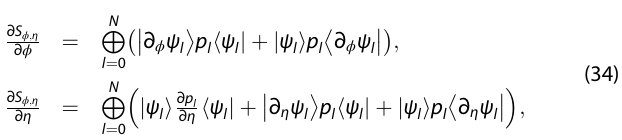
Fig. 3 Schematic for optimal estimation of the phase shift ϕ and interferometer transmissivity η using a two mode state ψ in de fi nite photon-number N . The measurement can be performed in two stages. The fi rst stage (green block) involves performing a projective measurement over the photon-number subspace to determine the number of photons lost, l . The outcome of this measurement is then used to select a three-outcome POVM { Π ( l ) } for the second stage (black box). This measurement strategy saturates not only the Nagaoka bound, but also the Holevo (cid:13) (cid:14) k η k (cid:3) l ð 1 (cid:3) η Þ l are the beam- state with rank N + 1. Here, b kl ¼ splitter coef fi cients and p l represents the probability of losing l photons. The partial derivatives of S ϕ , η share the same direct sum